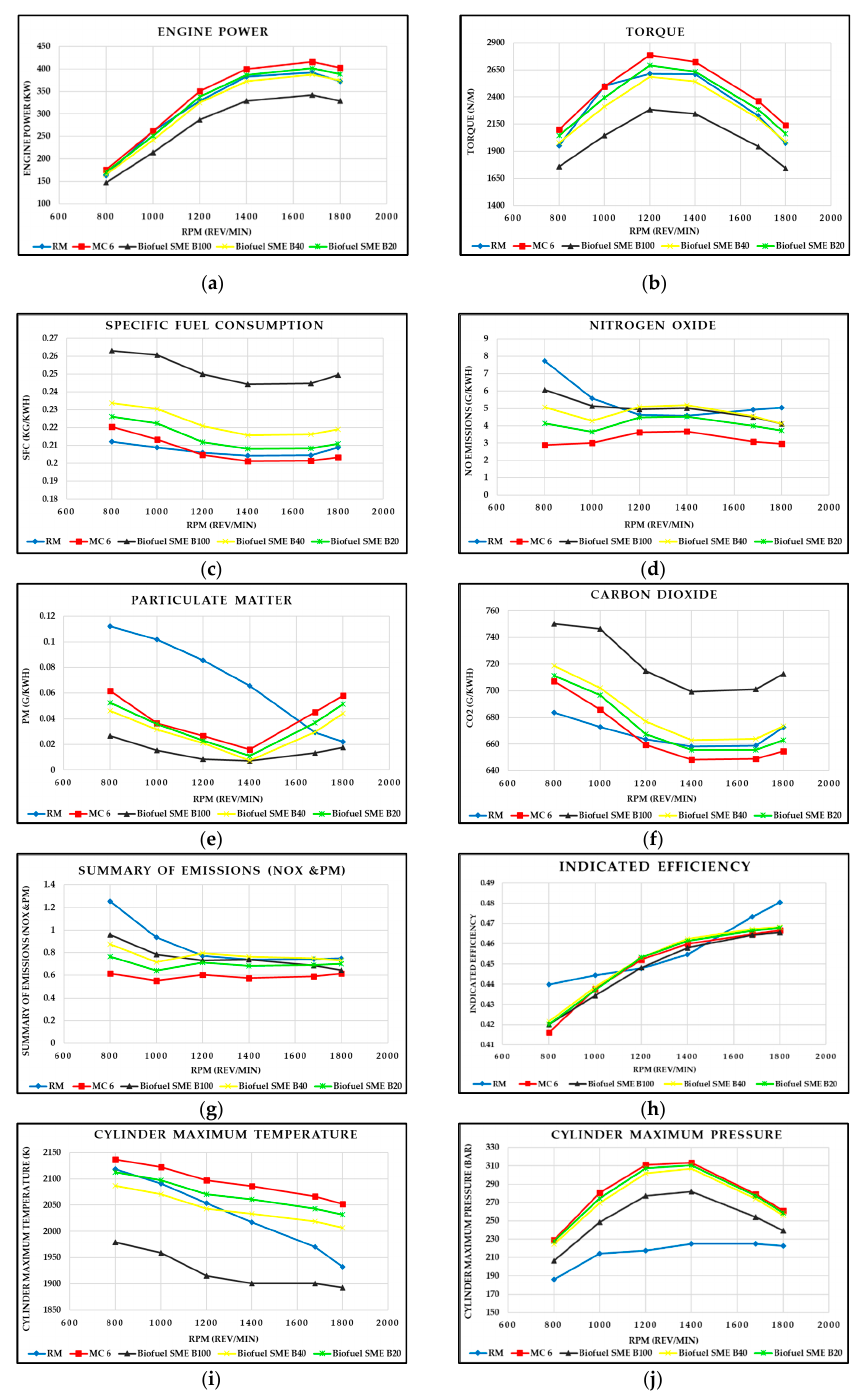
Figure 9. Performance and emissions of the RM and MC 6 models with diesel fuel and MC 6 model with SME biodiesel blends. ( a ) Engine power (kW), ( b ) torque (Nm), ( c ) specific fuel consumption (kg/kWh), ( d ) nitrogen oxide (g/kWh), ( e ) particulate matter emissions (g/kWh), ( f ) carbon dioxide (g/kWh), ( g ) summary emissions (NOx and PM), ( h ) indicated efficiency, ( i ) cylinder maximum temperature (K) and ( j ) cylinder maximum pressure (bar).